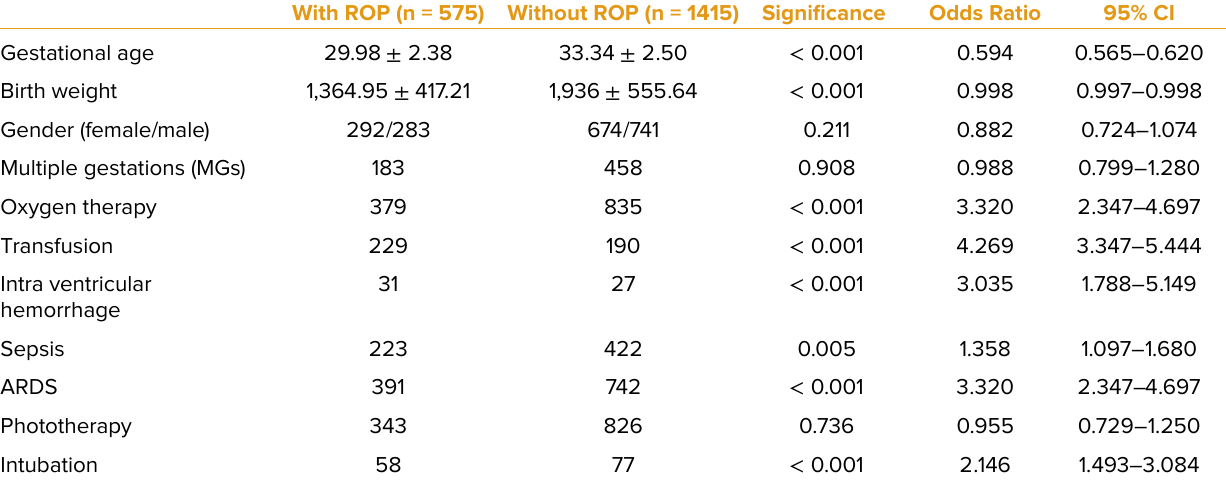
Table 2. Data of univariate regression analysis of different risk factors in the development of retinopathy of prematurity With ROP (n = 575) Without ROP (n = 1415)